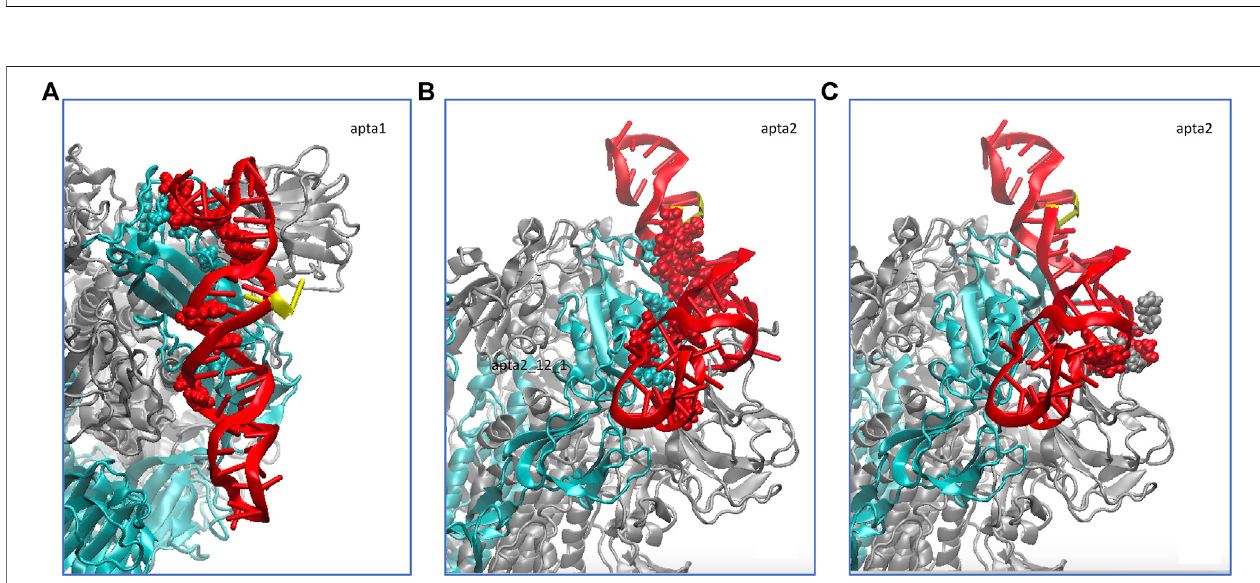
FIGURE 5 | Schematic of the hydrogen bonds formed by the DNA aptamers (red ribbons) interacting with the non-glycosylated S-protein trimer in the closed conformation. (A) Binding of apta1 to the S1-RBD subdomain of monomer 1 (cyan ribbons). H-bonded residues are depicted with atomic spheres, cyan for the protein and red for the DNA; the 5 ′ and 3 ′ ends of the DNA are depicted in yellow. (B) Binding of apta2 to the S1-RBD subdomain of monomer 1. (C) Extra hydrogen bonds formed by apta2 with the N subdomain of the adjacent monomer 2.